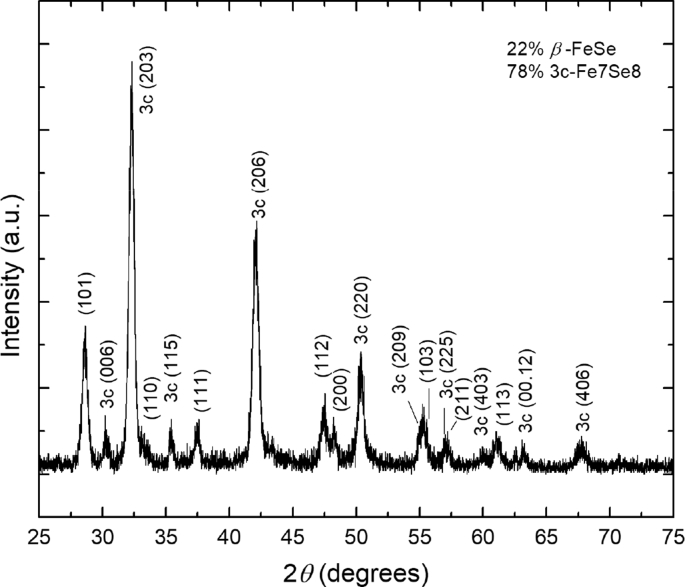
Undoped FeSe target XRD shows a mixture of 22% β-FeSe and 78% 3c-Fe7Se8.